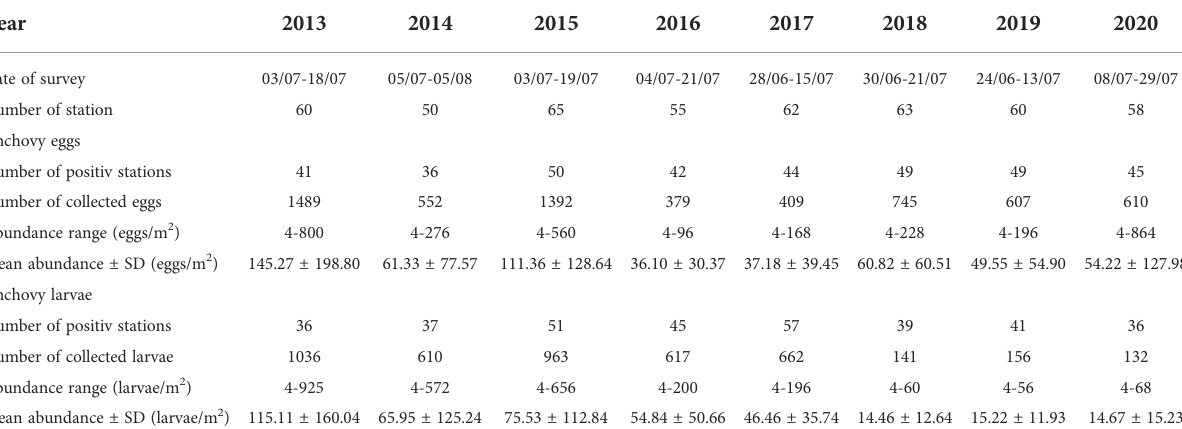
TABLE 1 Overview of sampling surveys done along the eastern Adriatic Sea (Croatian fi shing ground) – date, number of sampling station as well as number of positive stations where anchovy early life stages (eggs and larvae) were collected, overall number of collected anchovy eggs and larvae per survey, their abundance ranges and mean values with its standard deviations